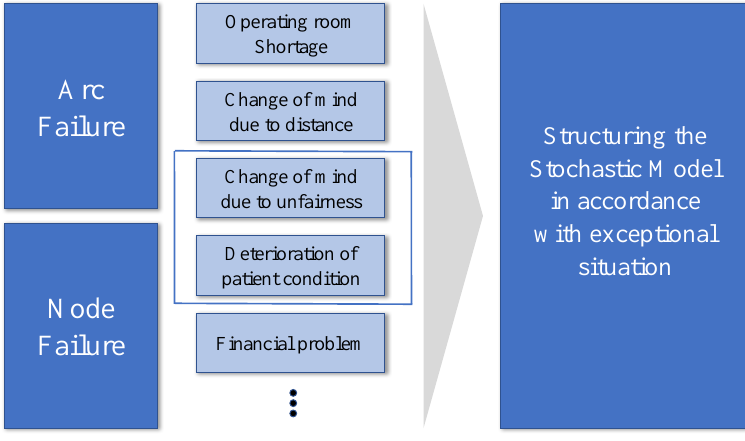
Figure 5. Various cases of KEP failures.